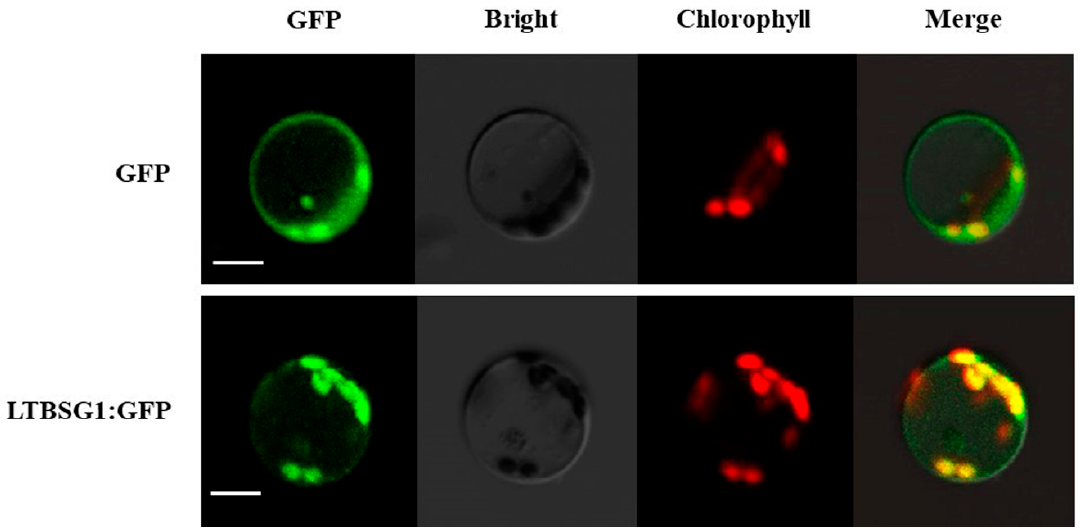
Figure 5. Subcellular localization of LTBSG1-GFP in rice protoplasts. Free GFP (Green Fluorescent Protein) (up panel) and LTBSG1-GFP (bottom panel) vectors were introduced into rice protoplasts. The horizontal four columns referred to GFP fluorescence images, bright images, chlorophyll spontaneous light images and their merged images for the same cells, respectively. Bars = 50 μ m.